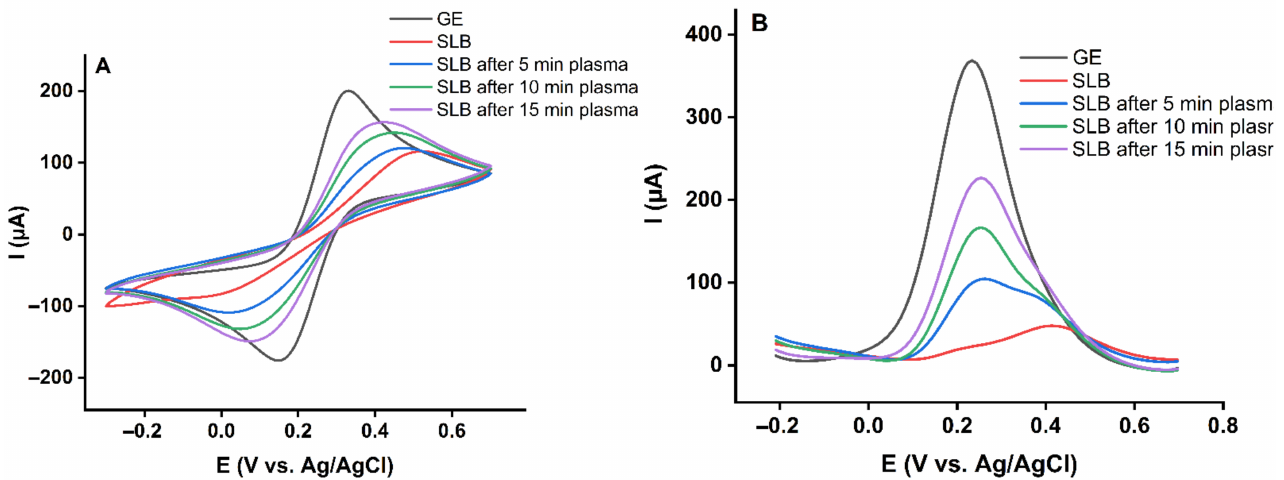
Figure 3. ( A ) Cyclic voltammograms and ( B ) differential pulse voltammograms of 10 mM K 4 [Fe(CN) 6 ] in PBS for the gold electrode (GE) and asymmetric gold supported lipid bilayer (SLB) with no cholesterol before and after 5, 10, and 15 min plasma